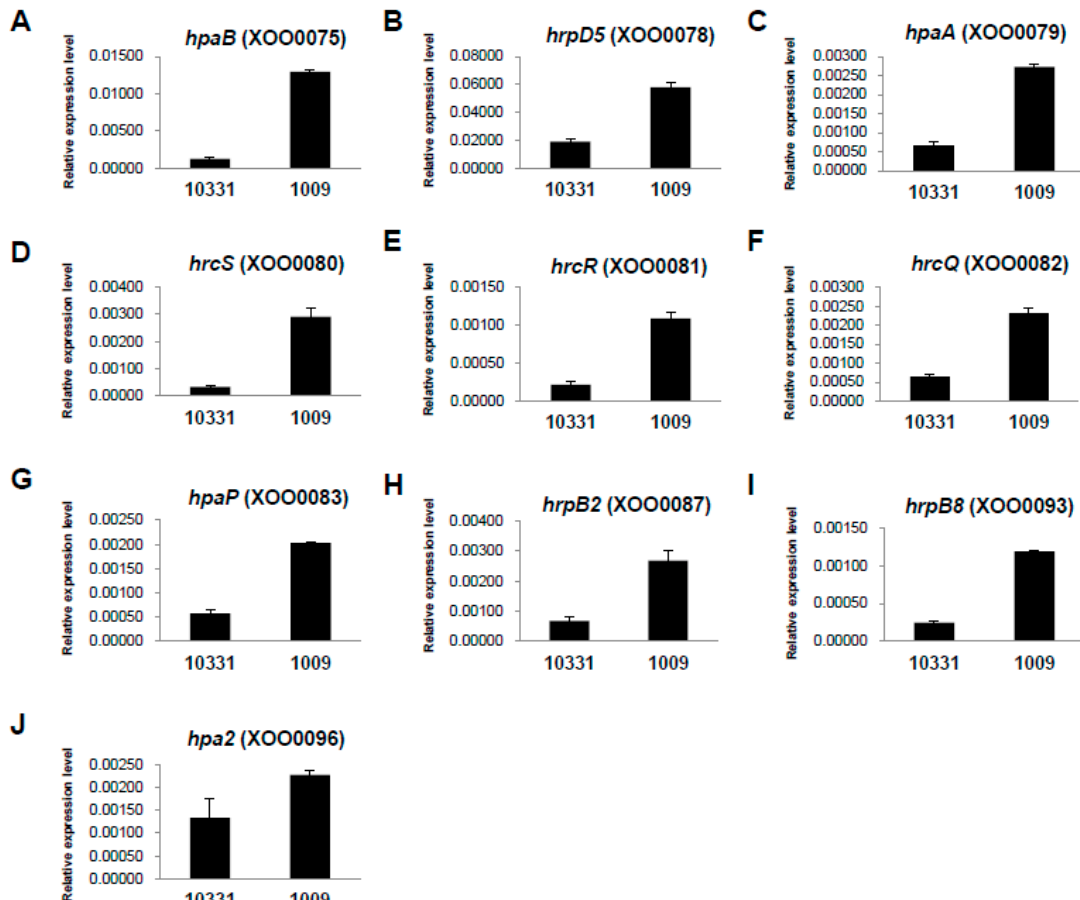
Figure 4. The expression patterns of hrp genes of the Xanthomonas oryzae pv. oryzae KACC10331 (K1 race) and HB1009 (K3a race) strains. The gene expression levels (arbitrary units) of hpaB ( A ); hrpD5 ( B ); hpaA ( C ); hrcS ( D ); hrcR ( E ); hrcQ ( F ); hpaP ( G ); hrpB2 ( H ); hrpB8 ( I ); and hpa2 ( J ) were normalized using 16S RNA as an internal reference. Gene expression levels were quantified by real-time RT-PCR.